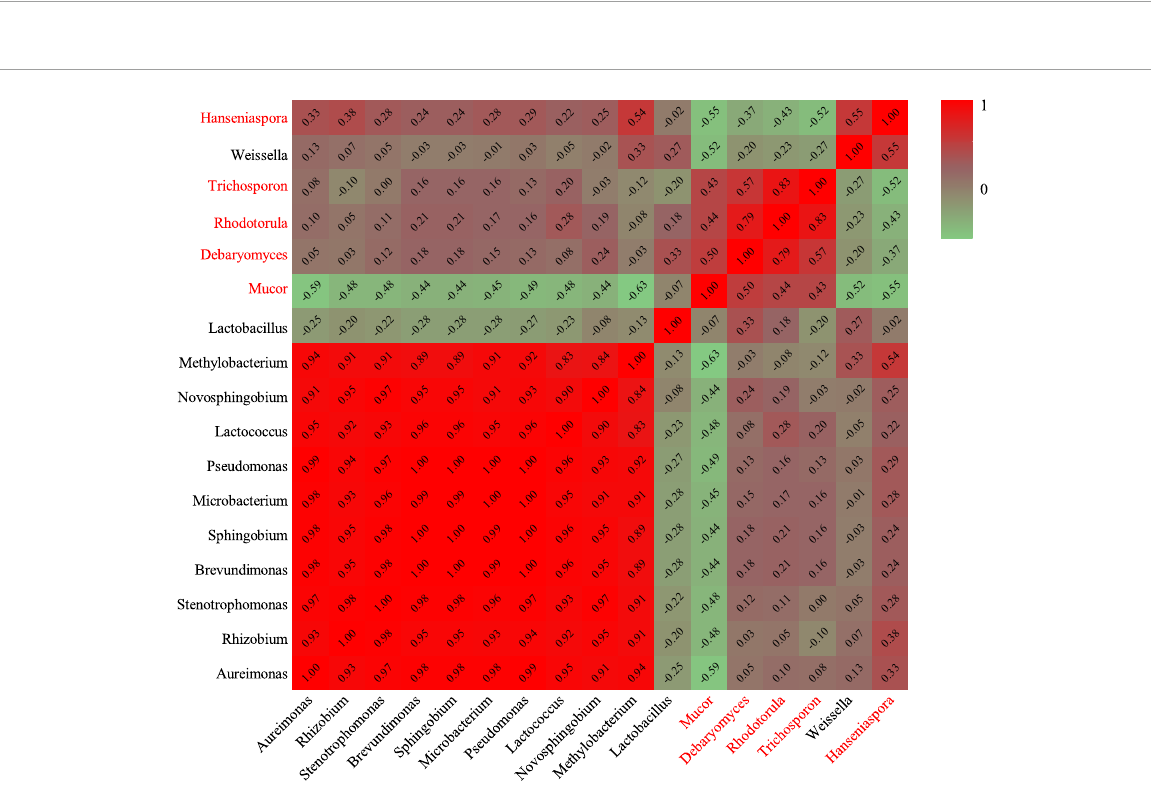
FIGURE4 Heatmap of Spearman rank correlation between microorganisms during the production of fermented minced peppers. Black letters are bacteria. Red letters are fungi.